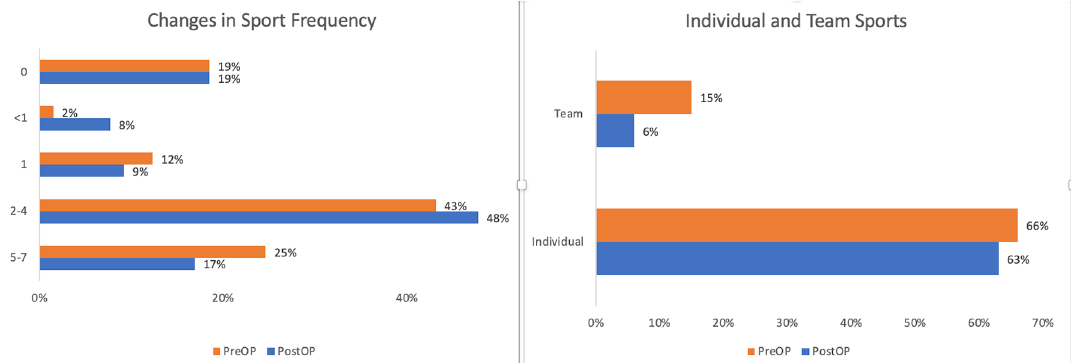
Figure 3. Changes of sport frequency and sport participation in team sports before and after surgery including the frequency of training (y-axis times/week) before and after surgery (left image) as well as the participation in individual and team sport activities (right